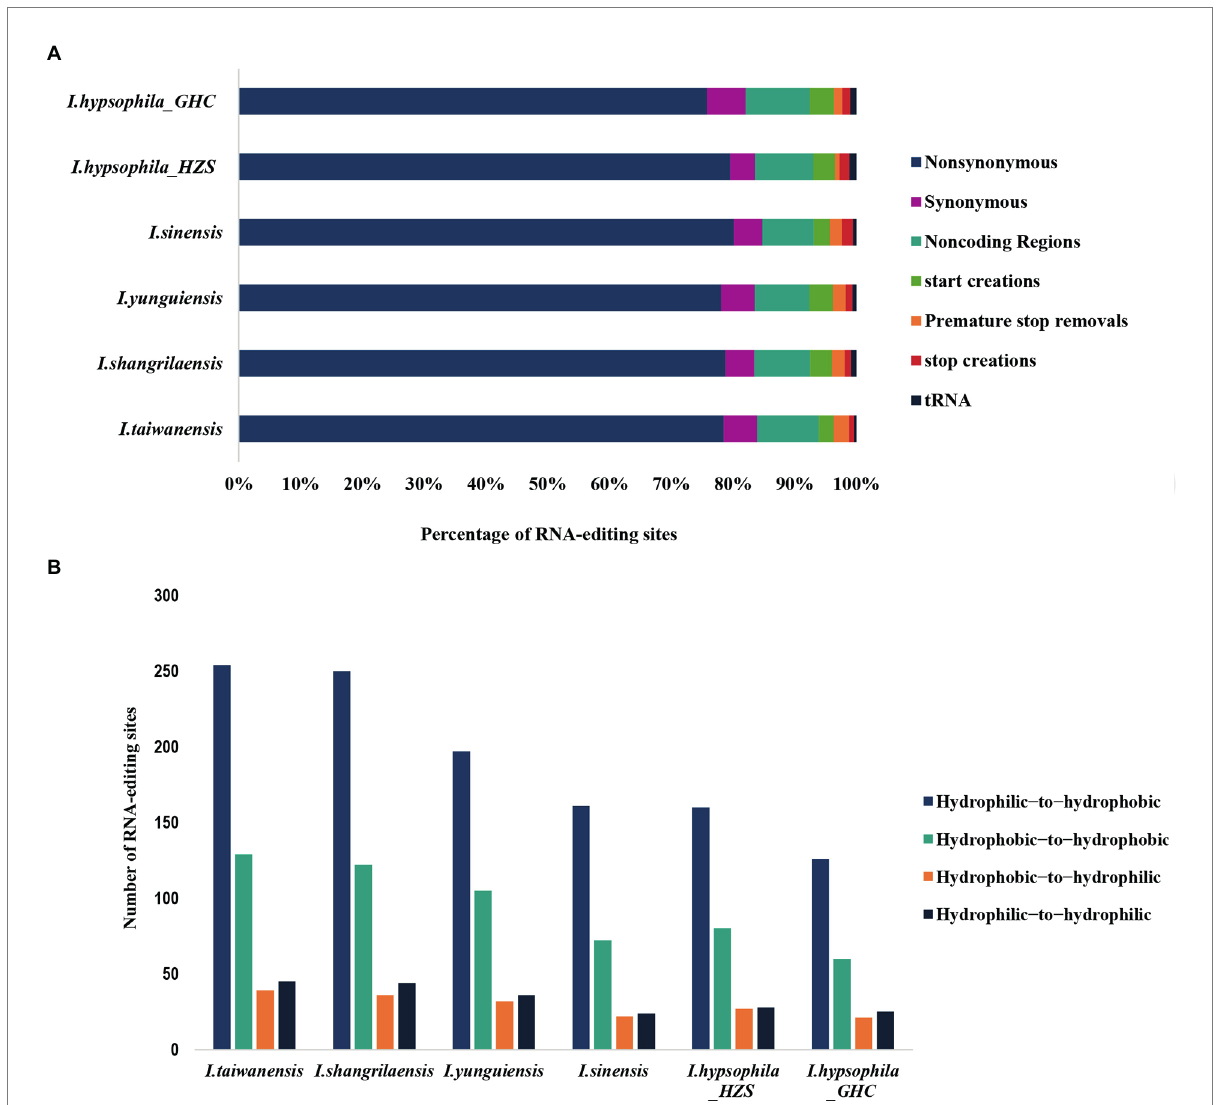
FIGURE 4 (A) Percentage of specific sequence modifications produced by RNA editing in sampled individuals. Histograms represent 100% of RNA edits detected. (B) Comparison of edit sites that lead to a change in hydrophobicity/hydrophilicity of the resulting amino acid via non-synonymous RNA